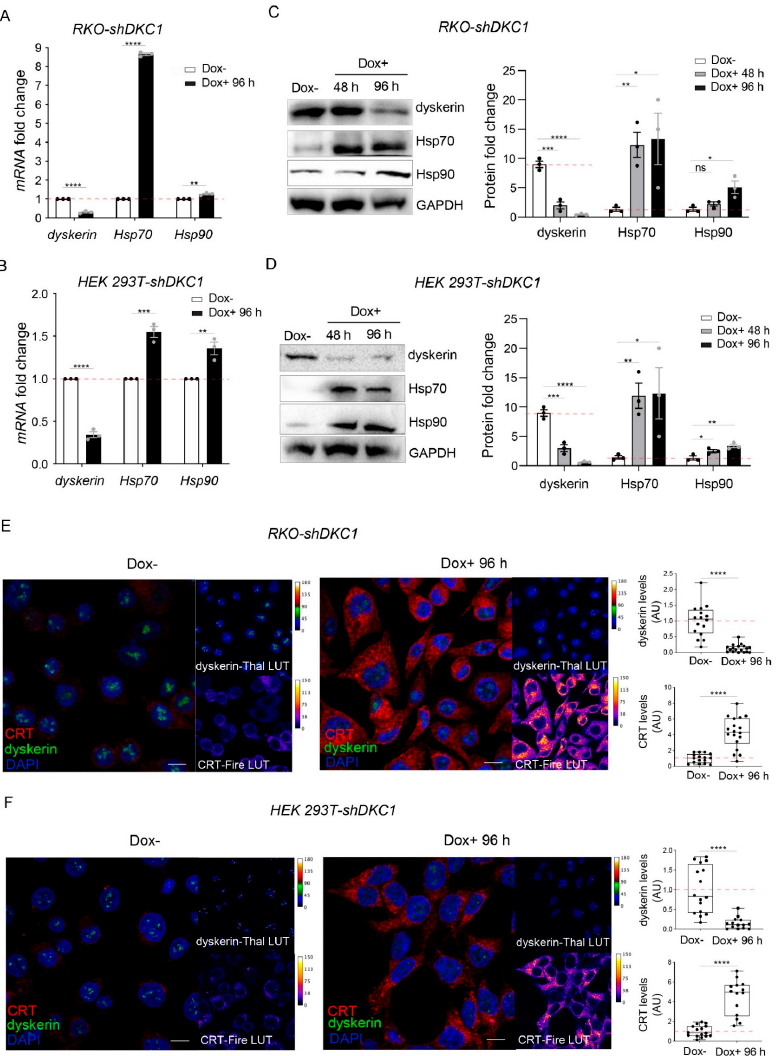
Figure 1. Dyskerin silencing stimulates the expression of chaperones involved in protein refolding. ( A , B ) qRT-PCR analysis showing the accumulation of Hsp70 and Hsp90 mRNAs in RKO-shDKC1 ( A ) and HEK 293T-shDKC1 cells ( B ) after DKC1 silencing induced by 96 h of Dox treatment. Data shown are relative to the untreated (Dox–) condition and as mean ± SEM ( n = 3). ( C , D ) Western blot analysis showing an increased accumulation of Hsp70 and Hsp90 in RKO-shDKC1 ( C ) and HEK 293T-shDKC1 cells ( D ) after dyskerin depletion induced by 48 or 96 h of Dox treatment. The intensity of the bands was normalized to GAPDH and the differential accumulations evaluated with respect to the Dox– condition. Data are presented as mean ± SEM ( n = 3). ( E , F ) Confocal images showing the increase in calreticulin (CRT) in RKO-shDKC1 ( E ) and HEK 293T-shDKC1 cells ( F ) treated with Dox for 96 h (Dox+) compared to their untreated control cells (Dox–). Scale bars 10 µ m. Nuclei were counterstained with DAPI. CRT immunoreactivity is in red or Fire-Lut (false color Fire-Lookup Table) in separate channels. Dyskerin immunoreactivity is in green or in Thal-Lut (false color Thal-Lookup Table). CRT and dyskerin accumulation levels were quantified in multiple cells ( n = 16 RKO-shDKC1 Dox–; n = 18 RKO-shDKC1 Dox+ 96 h; n = 16 HEK 293T-shDKC1 Dox–; n = 14 293T HEK 293T-shDKC1 Dox+ 96 h), normalized and reported relative to the Dox– condition as mean ± SEM. An unpaired one-tailed t -test was used in pairwise comparisons with respect to the Dox– condition in all statistical analyses in this figure (**** p < 0.0001; *** p < 0.001; ** p < 0.01; * p < 0.05; ns, p >